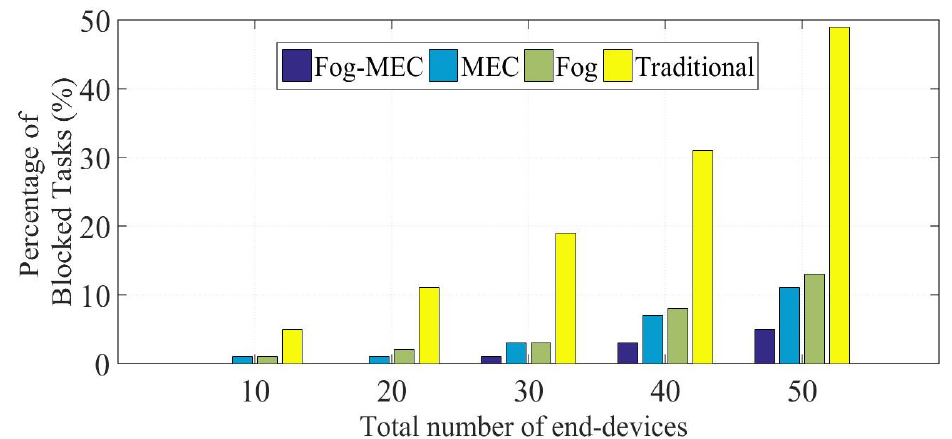
Figure 8. Percentage of blocked tasks for the proposed fog-MEC model compared to other existing systems.